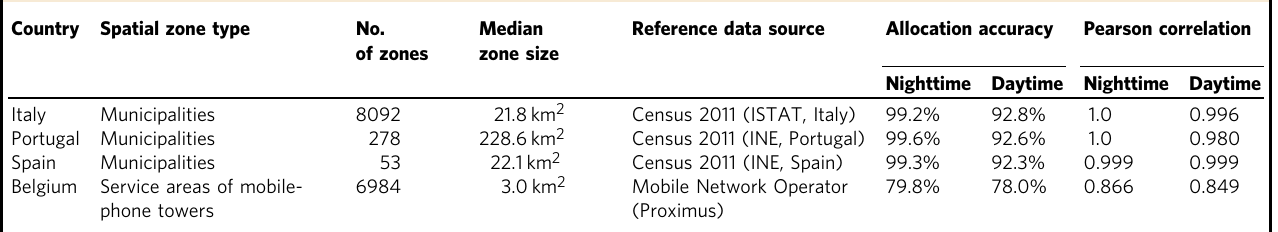
Table 1 Summary of the results of the cross-comparison exercise. Country Spatial zone